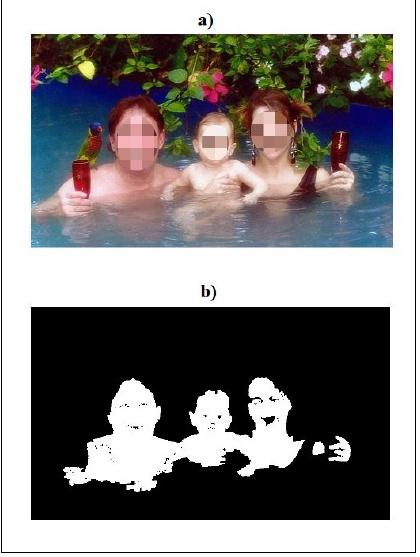
Figure 13. Input image for the example considering the presence of more than one person in the scene: ( a ) input and ( b ) ground truth.